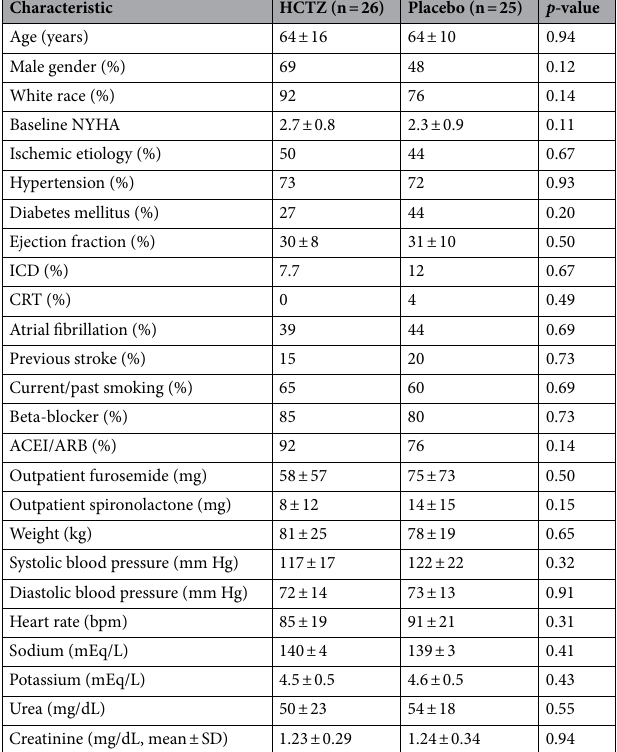
Table 1. Demographic and clinical characteristics. Plus–minus values are means ± standard deviation. ACEI angiotensin-converting enzyme inhibitor, ARB angiotensin II receptor blocker, CRT cardiac resynchronization